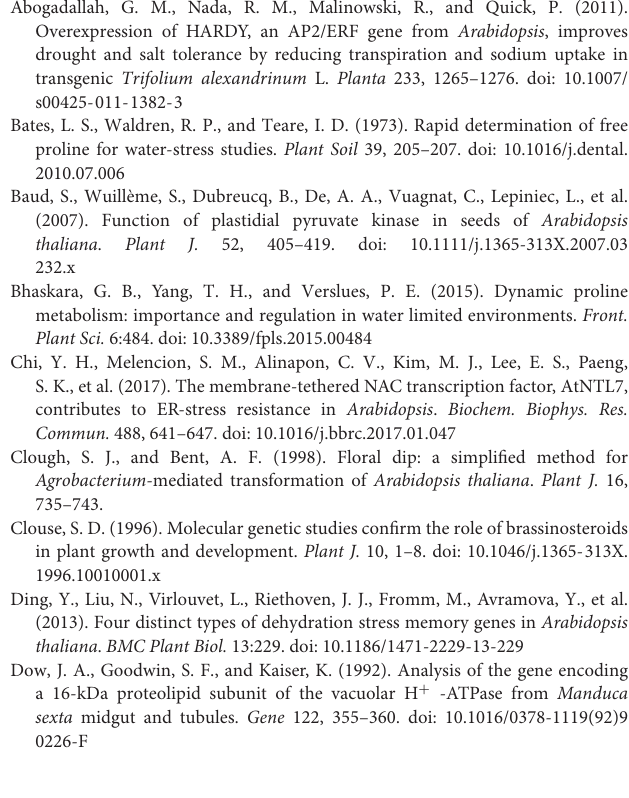
FIGURE S1 | Content of proline in transgenic lines, mutant lines and Col-0. The content of proline in HE and R lines was higher than that in Col-0 and the M lines under salt stress. All bars represent the mean ± SD, with three biological replicates in the experiment and each biological replicate with 20 plants; bars labeled with letters are significantly different at P < 0.05 by Duncan’s test. FIGURE S2 | Phenotypes of different lines in the TM-induced ER-stress. (A) Phenotypes of Col-0 and HE, M and R lines on 0.15 µ g/mL TM 1/2 MS medium. (B) The phenotypic statistical parameters of different lines. Expanding cotyledons, and with normal cotyledons, indicated that seeds grew well on the 0.15 µ g/mL TM 1/2 MS medium; germination represented plants that could germinate on the medium but with poorly developed cotyledons; non-germination represented plants that could not germinate on the medium. All the results were calculated from results of three independent experiments (36 seeds for each experiment). All bars represent the mean ± SD ( n = 3). FIGURE S3 | Analysis results of Gene Ontology for the candidate target genes of EsNAC1 in Arabidopsis. Binding situation of EsNAC1 quantified by the percent of genes ( x -axis) in different gene ontology terms ( y -axis) (with the number of genes, p -value of enrichment) via the color of each square mapped to the peak scores. FIGURE S4 | Distribution of motifs recognized by EsNAC1 or RD26 in the promoter regions of some targeted genes. Blue square, CATG; Orange square, CACG; Green square, TATA-box predicted by the web service of PlantCARE.